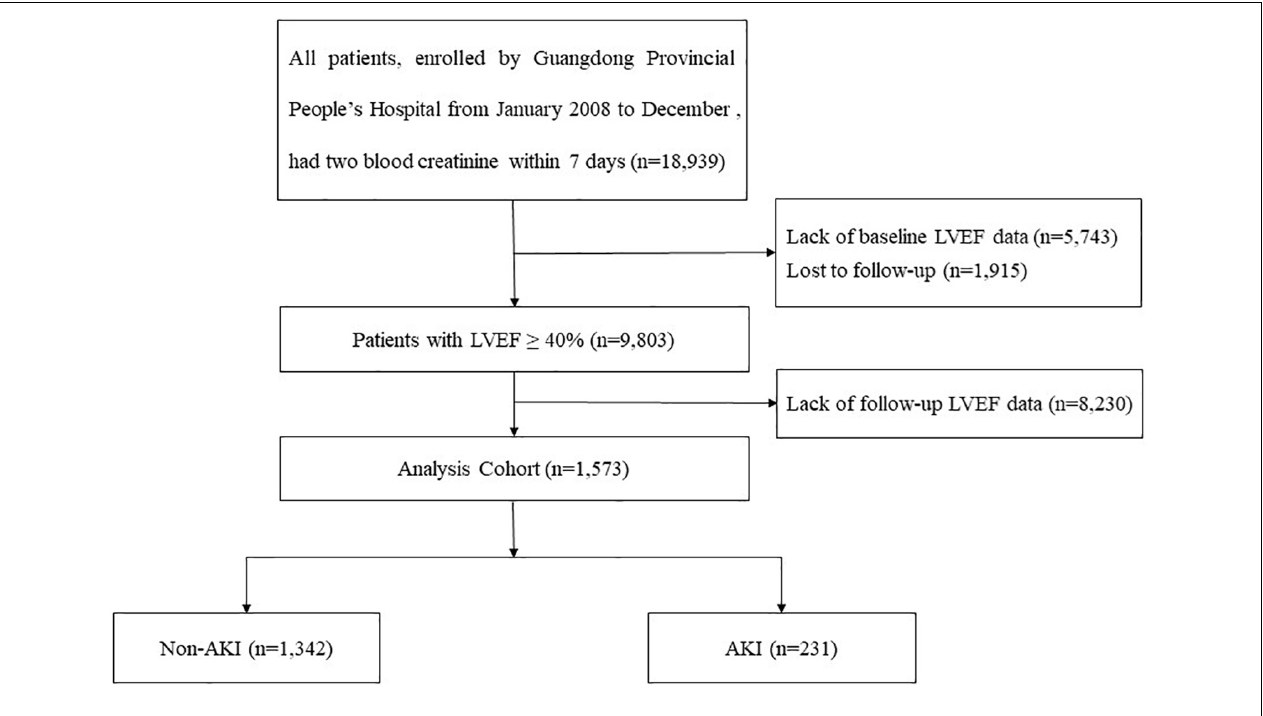
FIGURE 1 | Flow chart of the study